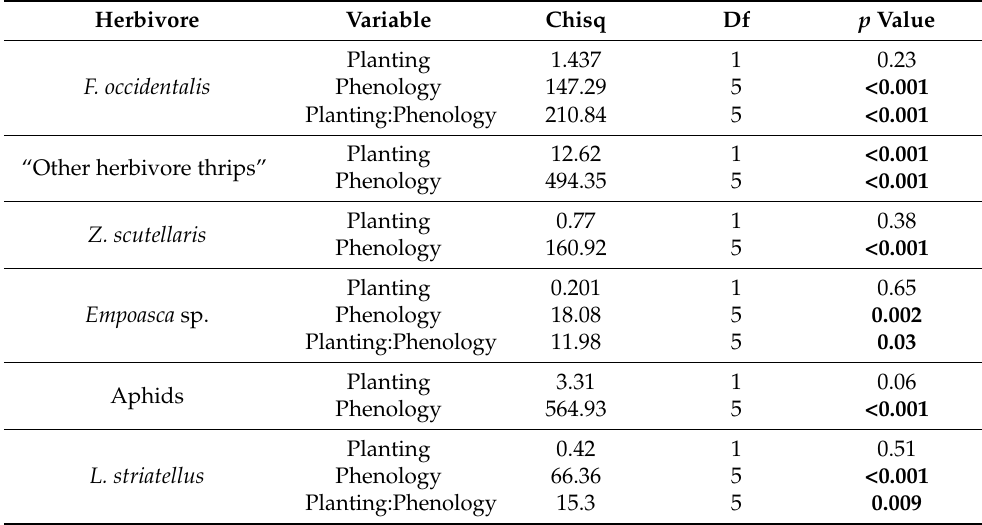
Table 1. Results of the generalized linear mixed models of herbivore abundance according to the maize phenology and planting period (early and late) and their interaction for all years.